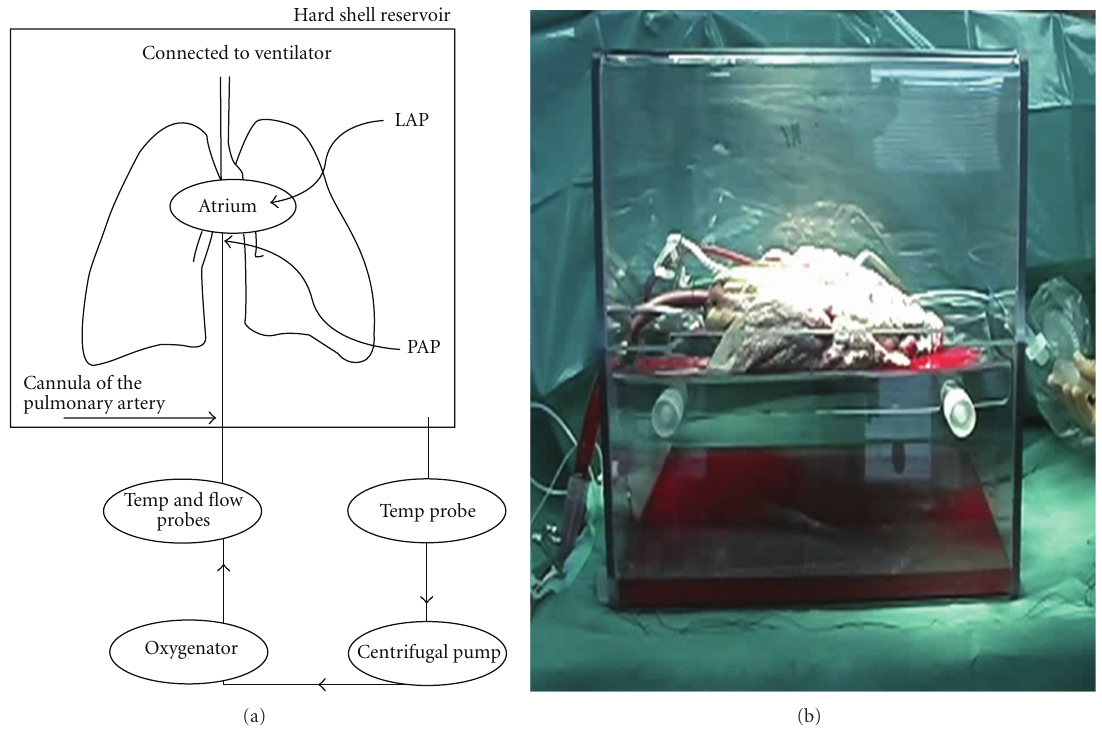
Figure 1: Flowchart showing the first part of the ex vivo reconditioning of donor lungs initially rejected donor lungs for clinical transplantation. During the first part of the process, the lungs are not ventilated and the perfusate blood is oxygenated. The temperature of the perfusate is gradually increased with a gradient ≤ 10 ◦ C to 32 ◦ C. The initial perfusion flow was 50–100 mL/min. The flow was slowly increased, and the pulmonary pressure was kept at ≤ 20mmHg. The left atrium pressure was maintained at 0 mmHg to prevent the development of